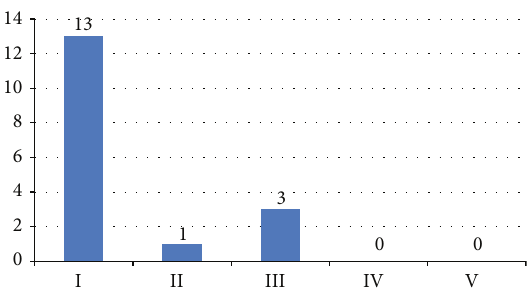
Figure 2: Level of evidence in the clinical